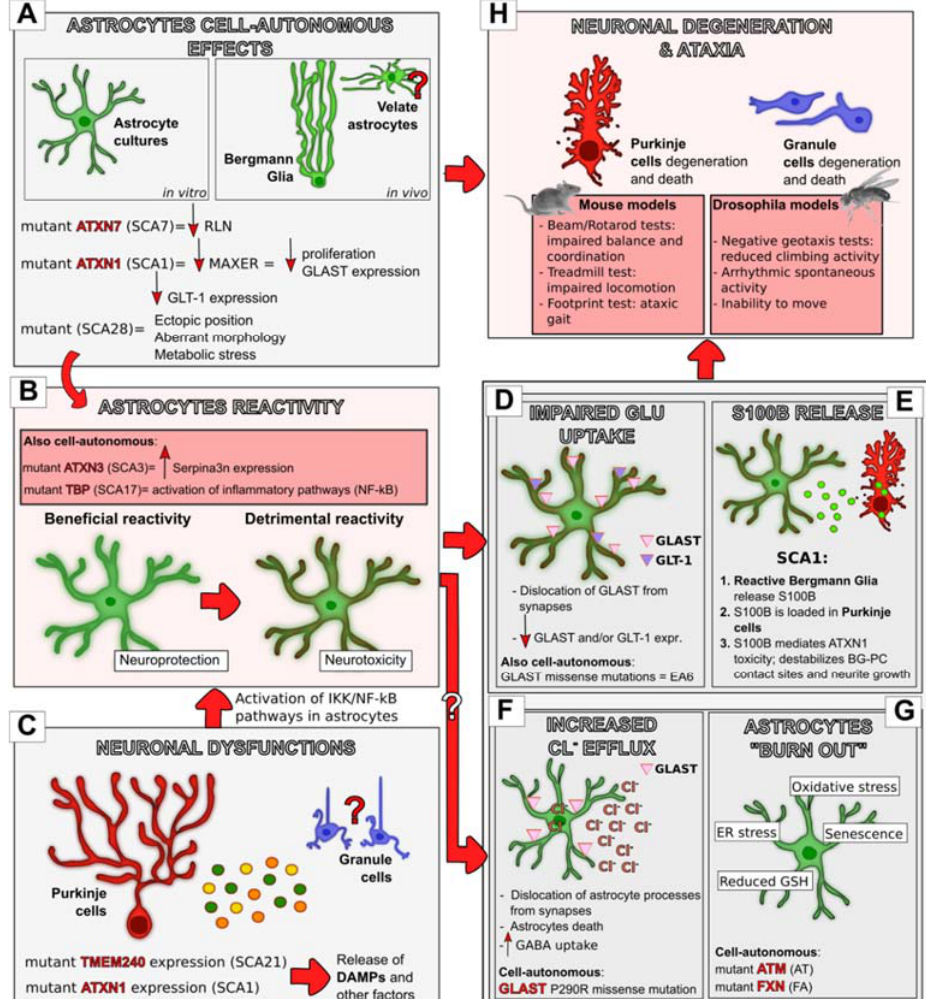
Figure 2. The multi-step hypothesis of astrocytes’ involvement in ataxia. Astrocytes contribute to neuronal degeneration and motor impairments in distinct phases of the disease course. The expression of ataxia-related mutant genes in astrocytes can cause cell-autonomous impairments ( A ) that can contribute to neurodegeneration either directly ( H ) or indirectly through the acquisition of a reactive phenotype ( B ). This was demonstrated to occur in distinct in vitro models, and, in vivo, in BG, while whether this happens also in the other cerebellar cortical astrocytes still needs to be clarified. Astrocytes’ reactivity can also result from neuronal impairments (( C ); demonstrated for PCs, likely to occur also in GCs), through the release from damaged neurons of DAMPs and other factors that can activate I κ B kinase (IKK) / NF-kB inflammatory pathways in astrocytes that, in turn, become reactive ( B ). Interestingly, astrocytes’ reactivity was shown to play a dual function in Spinocerebellar Ataxia (SCA1) progression, first beneficial and later detrimental. Whether this holds true also for other forms of ataxia still needs to be elucidated. Reactive astrocytes, in turn, trigger neurodegeneration through distinct mechanisms, like the impairment of glutamate uptake ( D ) and the release of the calcium-binding protein S100B ( E ). Other neurotoxic mechanisms were shown to be an increase in the chloride e ffl ux from astrocytes ( F ) and their accumulation of stress responses ( G ). Both these mechanisms were described to result from cell-autonomous impairments in astrocytes but may also result indirectly from their acquisition of a reactive phenotype. Glu, Glutamate, Big red arrows, successive step; small arrows, increase (facing up) or decrease (facing down). White question mark, hypothetical successive step; red question mark, hypothetical cellular